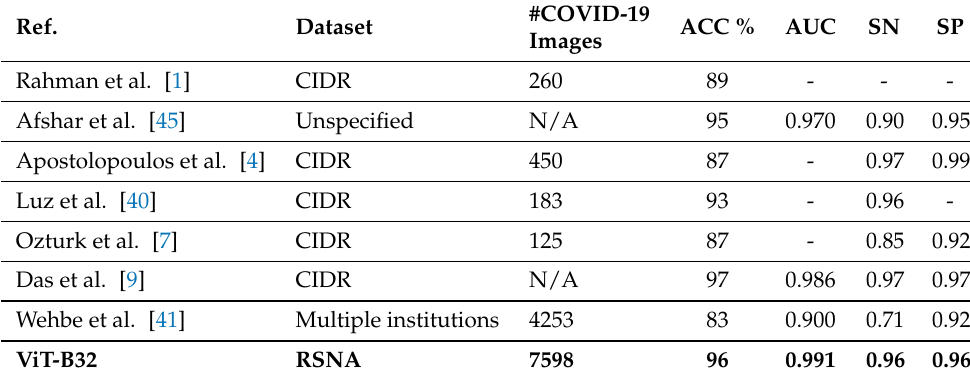
Table 4. Performance comparison with state-of-the-art methods using CXR images for COVID-19